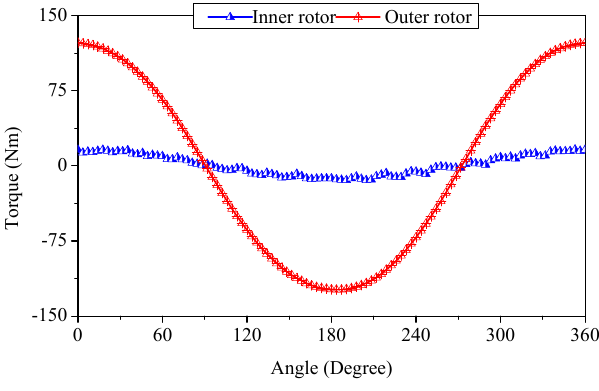
Figure 17. Torque–angle relationship.